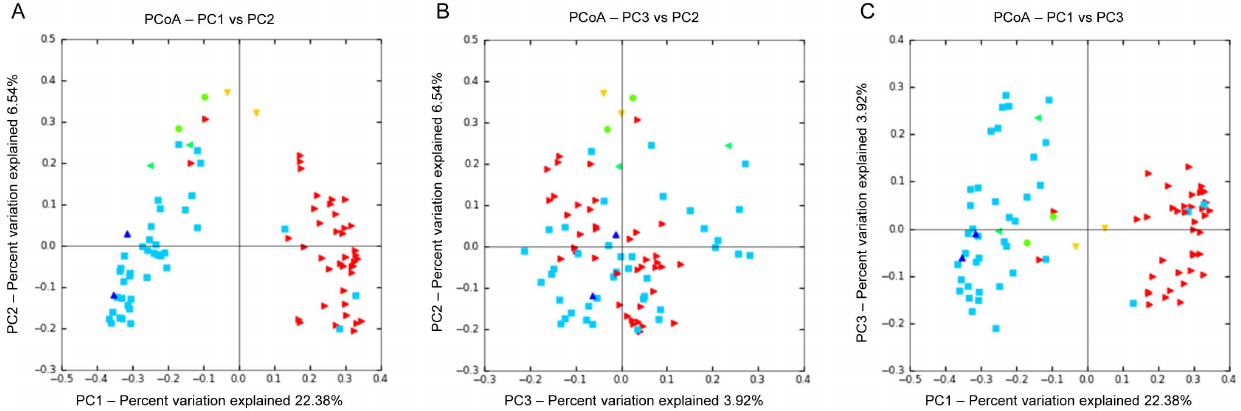
Figure 5. Principal coordinates analysis (PCoA) of unweighted UniFrac distances of 16 S rRNA genes. Analysis for 42 foals at 2 (red triangle), 7 days old (yellow triangle), 14 (green dot), 21 (green triangle), 30 (light blue square), and 56 days of age (dark blue triangle). The 3 panels represent the comparison of the first 2 principal components (A), the second and third principal components (B), and the first and third principal components (C). Strong effects of age can be seen in panels A and C, and differences among age groups were significant (ANOSIM, P